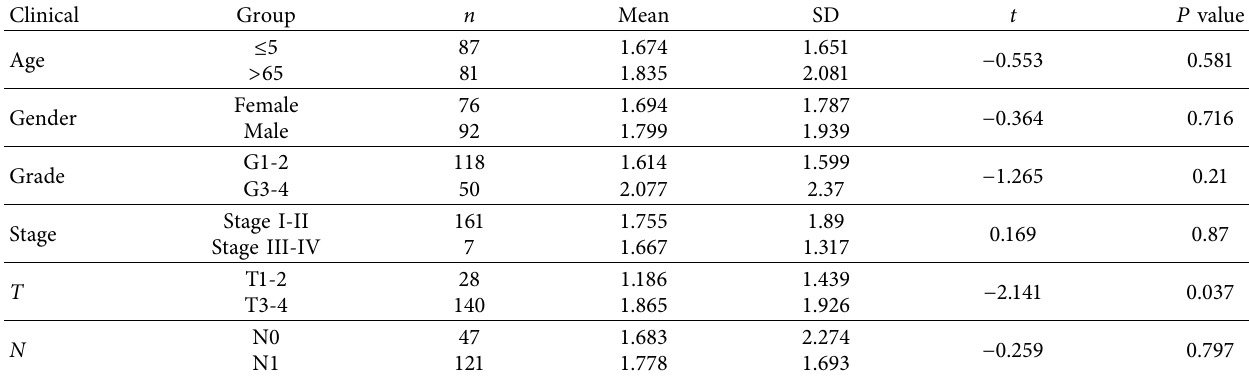
Figure 7: Predictive performance evaluation of the risk model based on the risk score and clinical factors using the forest plots for univariate (a) and multivariate (b) Cox regression. Table 3: Correlation analysis of clinical characteristics of PC patients and risk